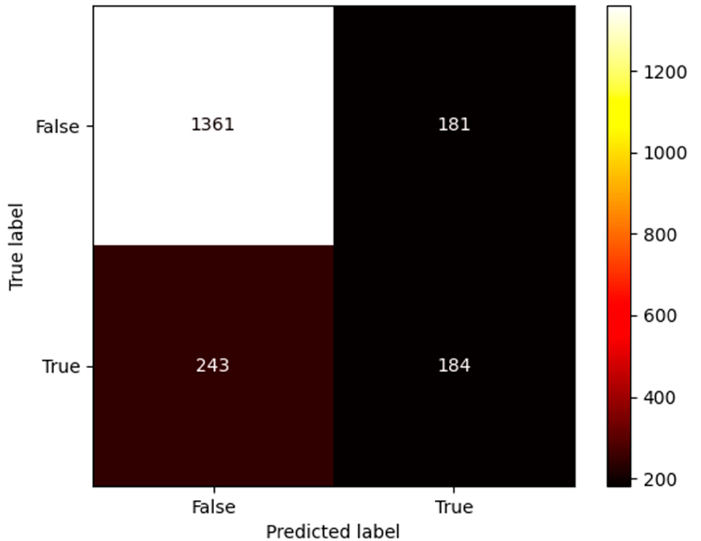
Figure 5. Pictorial representation of the confusion matrix subjected to Ethereum Fraudulence Pre- diction with detailed annotations. The Chaos Feature Extractor suspected 184 transactions comple- mented with AdaBoost to be fraudulent which were in fact fraudulent. The algorithm declared 1361 transactions to be genuine which were in fact genuine.